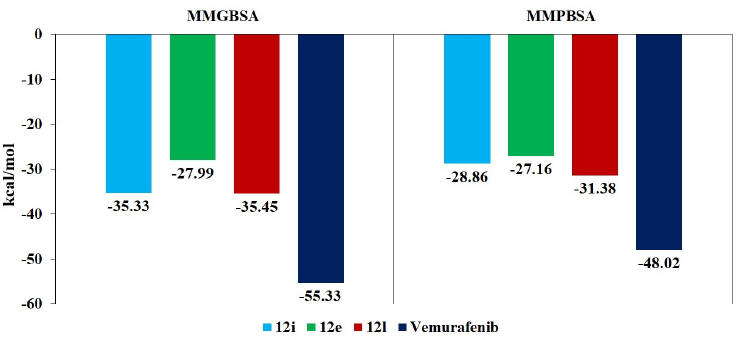
Figure 6. MMGBSA and MMPBSA binding energies as per the last 20 ns of molecular dynamics simulation of compounds 12i, 12e and 12l and reference ligand with the binding site of V6000EBRAF protein.